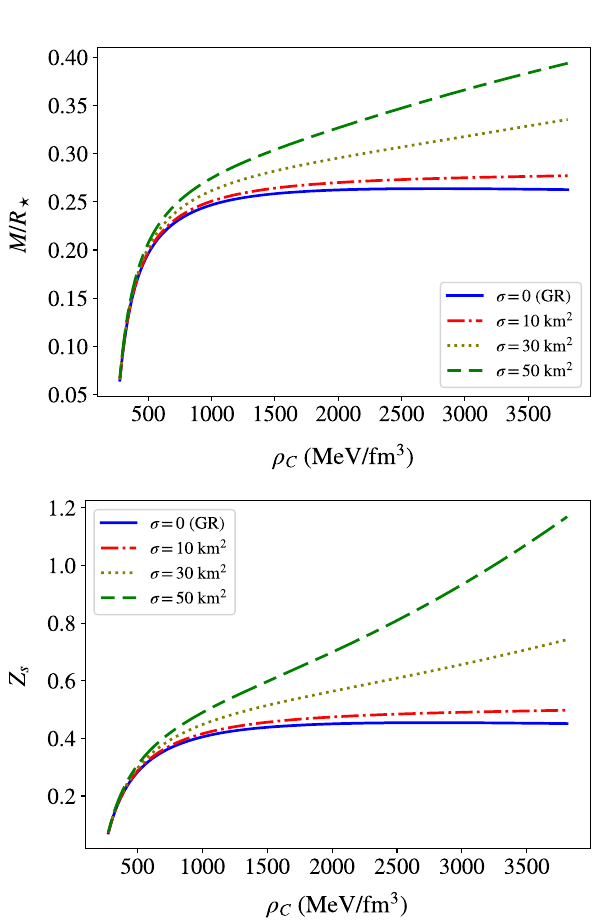
regime, GMC outcomes would be the same as the GR